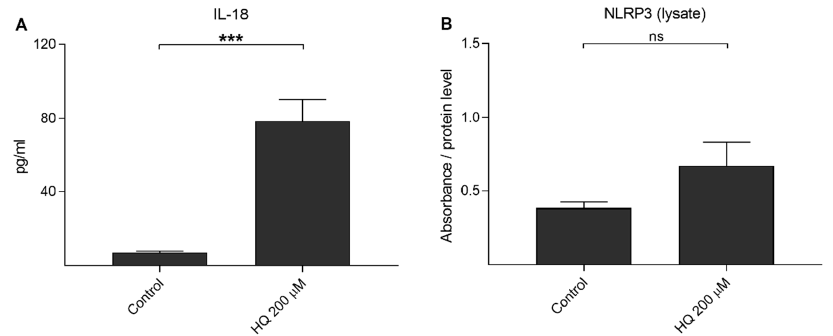
Figure 5. The effect of 200 μ M hydroquinone (HQ; 18 h) on the IL-18 secretion ( A ) and on the intracellular NLRP3 level ( B ) in unprimed ARPE-19 cells. An untreated control group was used as the control for hydroquinone treatment. IL-18 concentrations in medium samples ( A ) were 4.552–10.556 pg/mL in the control and 32.132–123.617 pg/mL in the HQ 200 μ M group. Absorbance values in ( B ) were 0.443–0.563 in the control and 0.345–0.579 in the HQ 200 μ M group. Data were combined from two independent experiments containing four ( A ) or two ( B ) parallel samples per group. Results are shown as mean ± SEM. *** P < 0.001, ns—not significant, Mann-Whitney U-test.